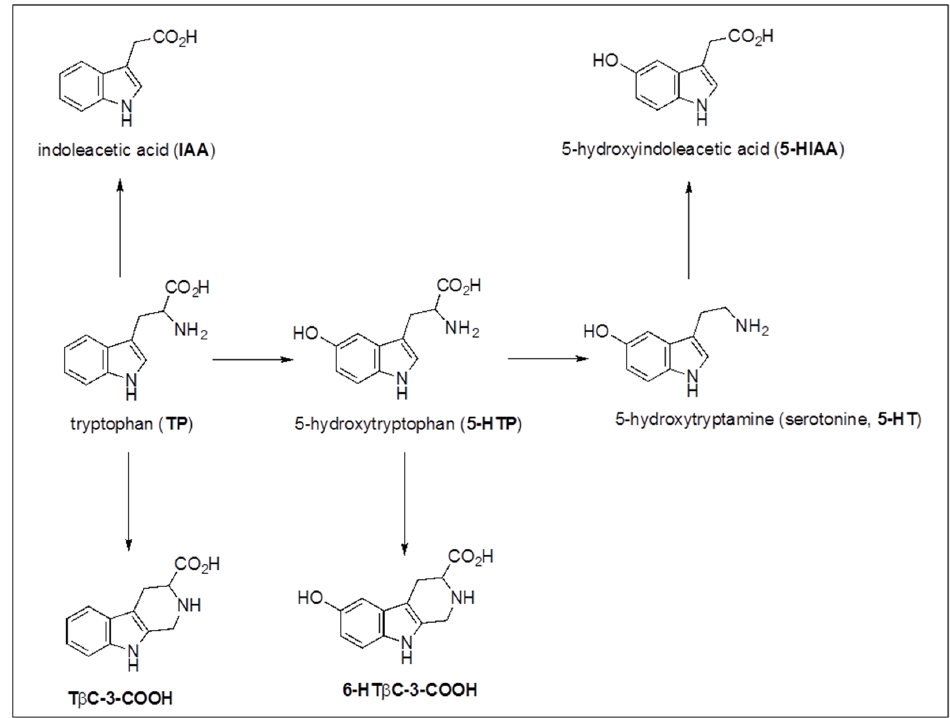
Scheme 1. Biosynthetic pathways of growth hormones and allelopathic molecules starting from tryptophan